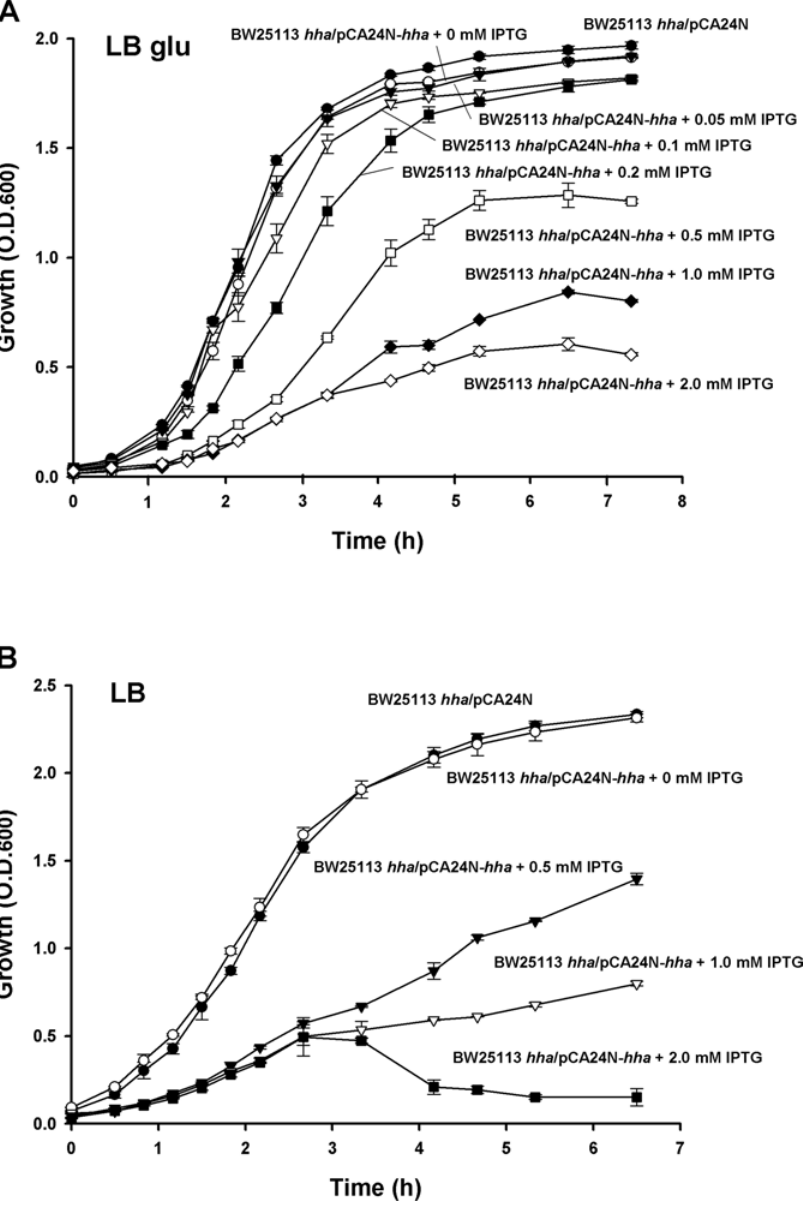
Figure 2. Hha reduces cell growth . Growth of BW25113 hha /pCA24N- hha at 37 u C in (A) LB and (B) LB glu. The experiment was performed in triplicate, and one standard deviation is